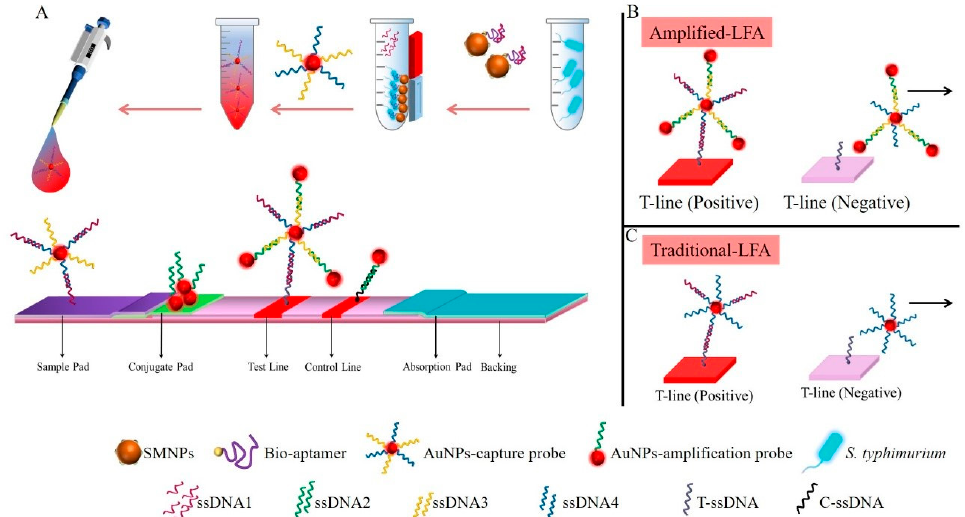
Figure 1. Lateral flow assay enhanced by multifold AuNPs combined with magnetic enrichment for Salmonella Typhimurium detection. Schematic illustration of the detection of Salmonella Typhimurium using AuNPs aggregates enhanced lateral flow assay ( A ); multifold AuNPs on test line in the presence ( left ) and absence ( right ) of Salmonella Typhimurium ( B ); single–dose AuNPs on the test line in the unenhanced lateral flow assay ( C